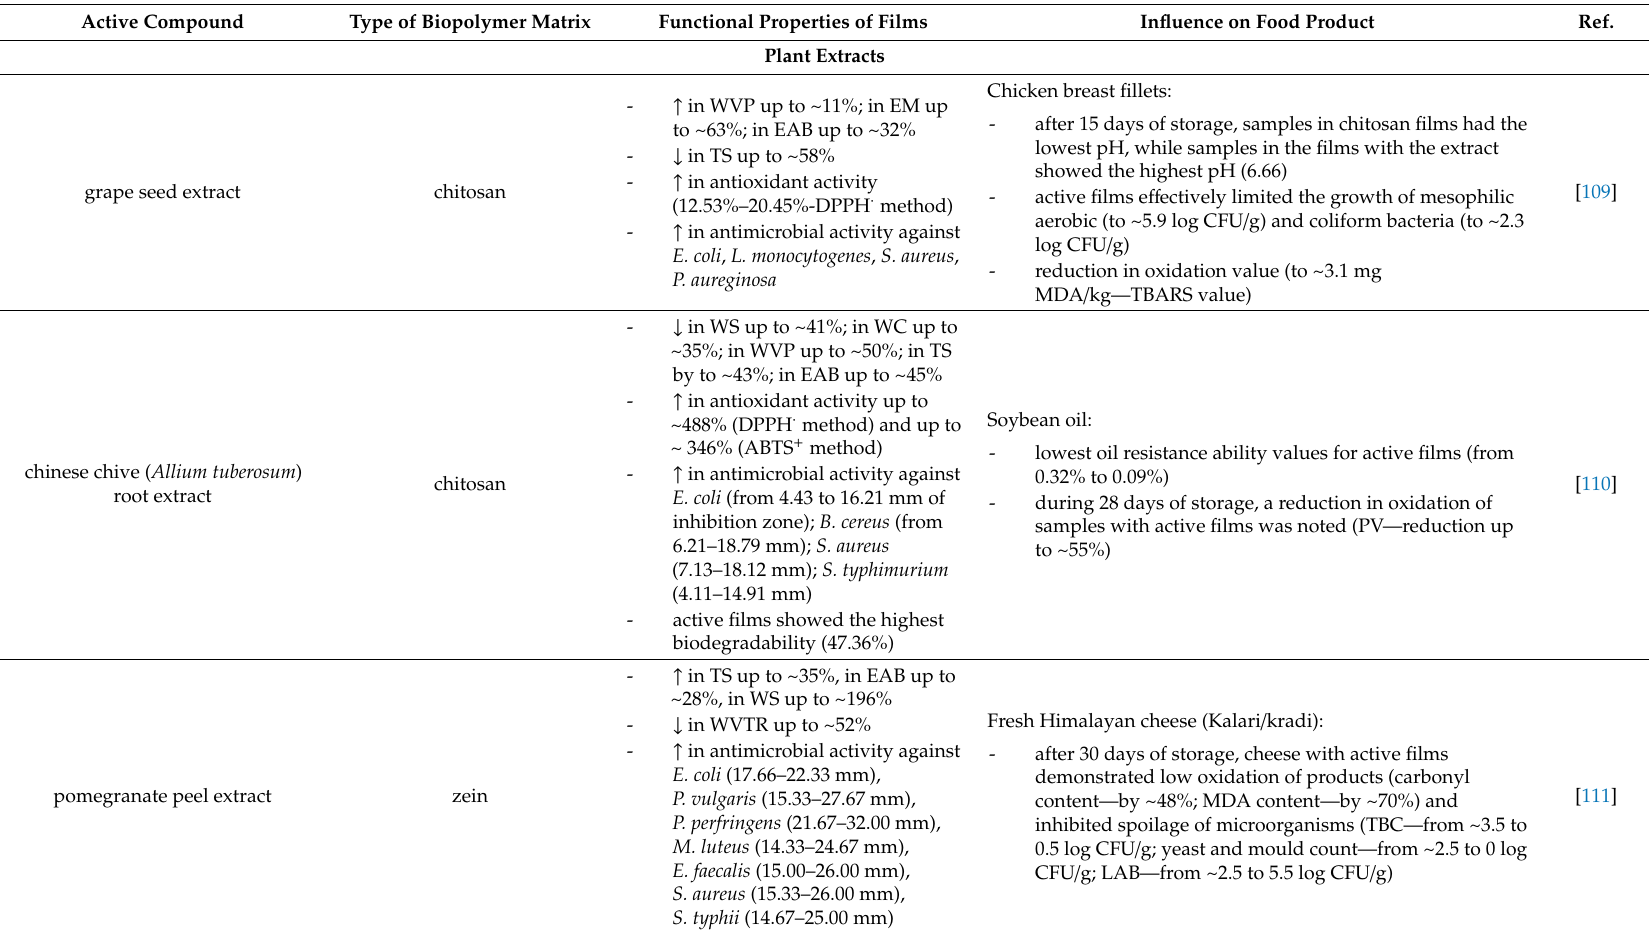
Table 3. Literature review regarding the use of active packaging materials on food